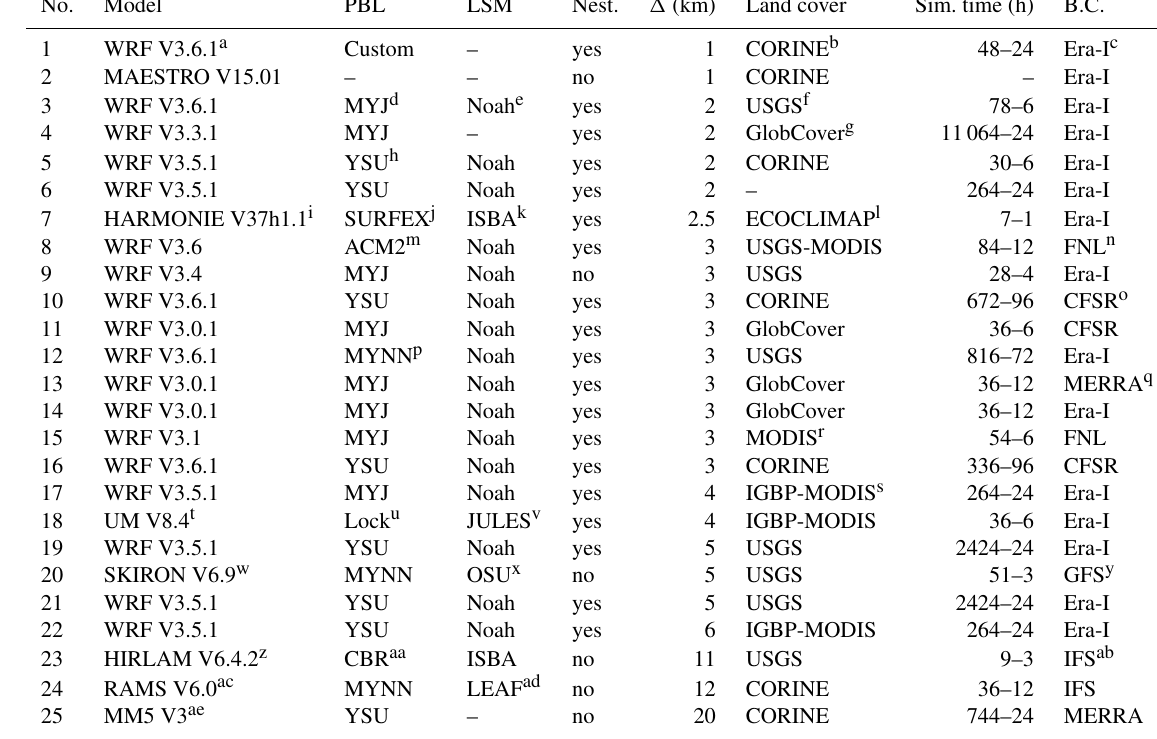
Table 4. Setup description of the 25 model setups ranked by horizontal grid spacing of the finest grid. The columns are the model name and version (model), the PBL scheme (PBL), the land surface model (LSM), whether nesting was used (Nest.), the horizontal grid spacing ( (cid:49) ), the land cover source, simulation and spin-up time (Sim. time), and initial and boundary condition data